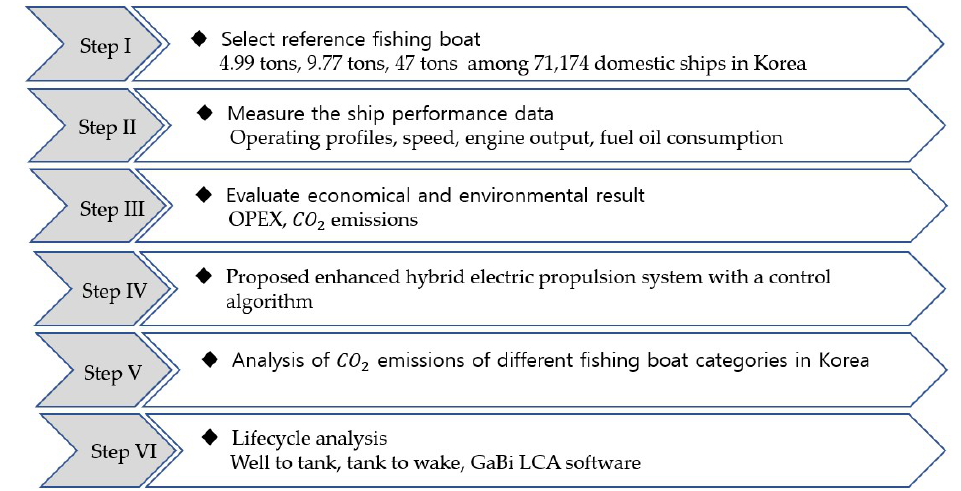
Figure 1. Figure 1. Methodology.